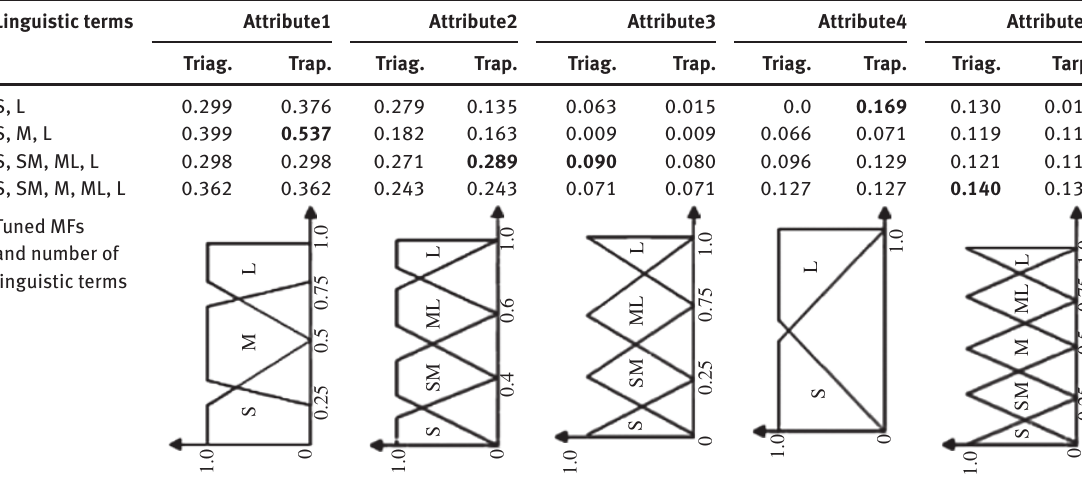
Table 2: Gain Ratios for Various Combinations of MFs and Number of Linguistic Terms. Linguistic terms Attribute1 Attribute2 Attribute3 Attribute4 Attribute5 Triag. Trap. Triag. Trap. Triag. Trap. Triag. Trap. Triag. Tarp. S, L 0.299 0.376 0.279 0.135 0.063